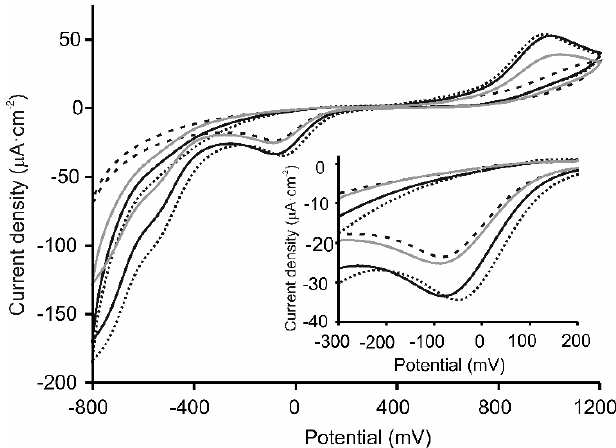
Figure 3. CV curves registered in catechol 10 −4 mol∙L −1 in 0.01 M phosphate buffer pH 7 as electrolyte at [(CHI)-(AuNPs)] 2 (dashed line), [(CHI)-(CuPcS)] 2 (solid grey line), [(CHI)-(CuPcS)-(CHI)-(AuNPs)] 2 (solid line), (CHI)-(AuNPs)-(CHI)-(CuPcS)] 2 (dotted line) electrodes at a scan rate of 0.1 V∙s −1 . The inset shows a magnification of the cathodic peak.